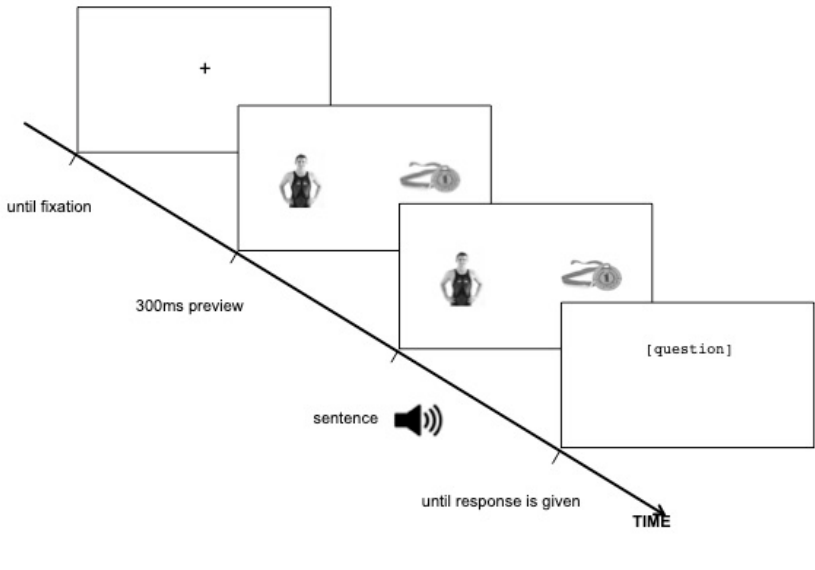
Figure 1: The structure of a